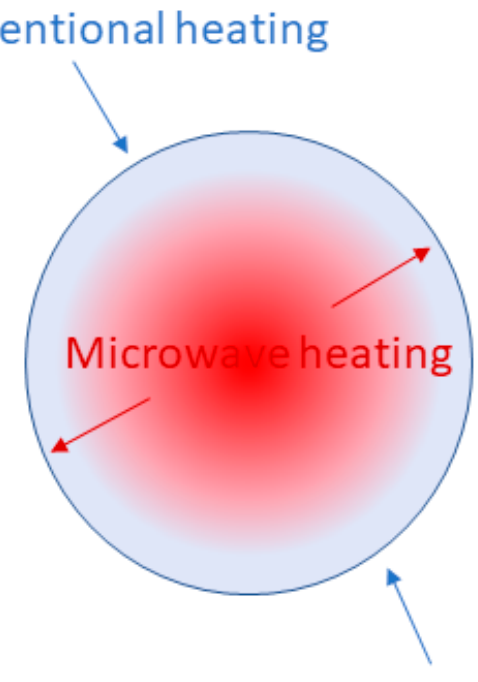
Figure 4. Microwave and conventional heating systems (Adapted from [1]).